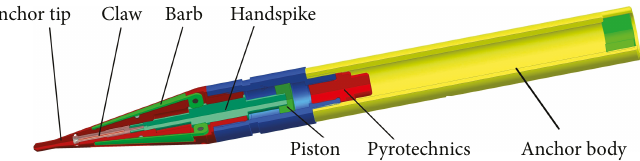
Figure 3: Schematic diagram of the penetrating unit.